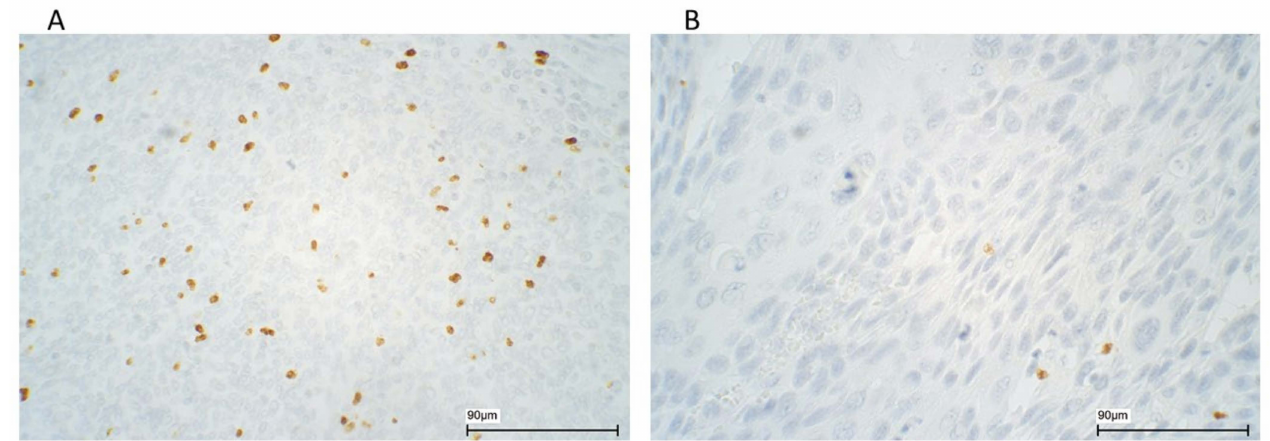
Figure 1. Immunohistochemical stainings of FOX P3 in HPV positive ( A ) and HPV negative ( B ) cases of oropharyngeal squamous cell carcinoma. Photomicrographs at × 400